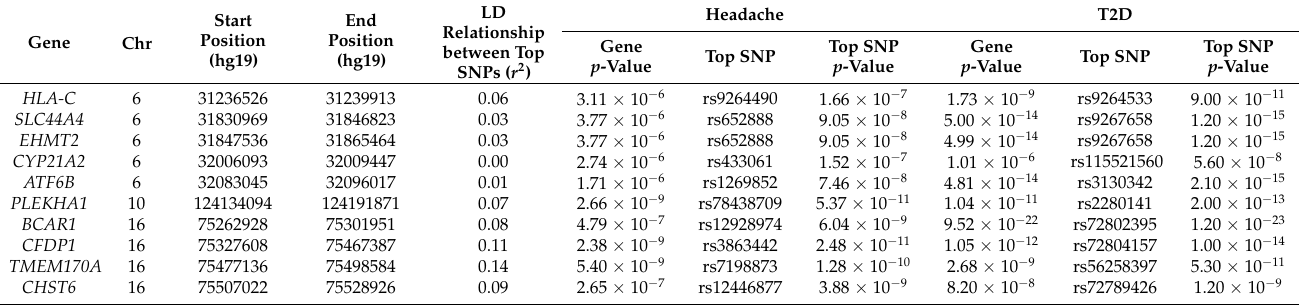
Table 8. Genome-wide significant genes for headache and